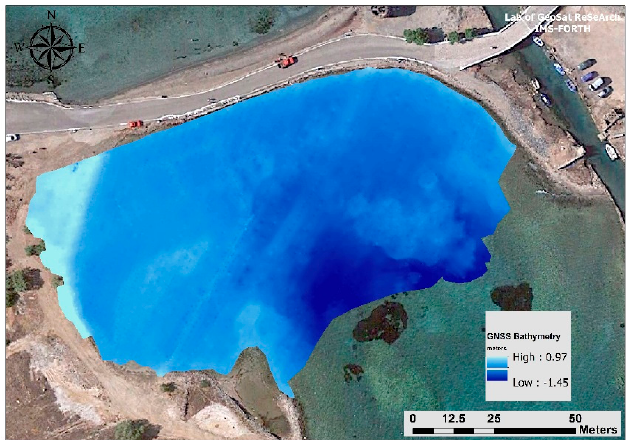
Figure 8. Digital bathymetry model of Elounda Bay compiled by the interpolation of the points logged with the Real Kinematic Global Navigation Satellite System (RTK-GNSS).